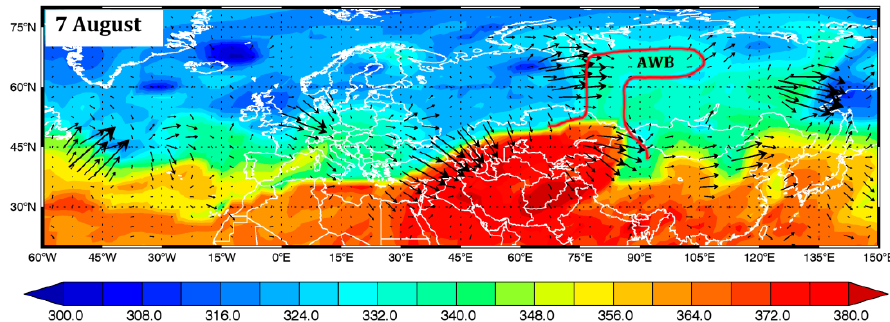
Figure 13. Circulation pattern (WAF and PV- Θ) on 7 August (6th period). Era -Interim data.